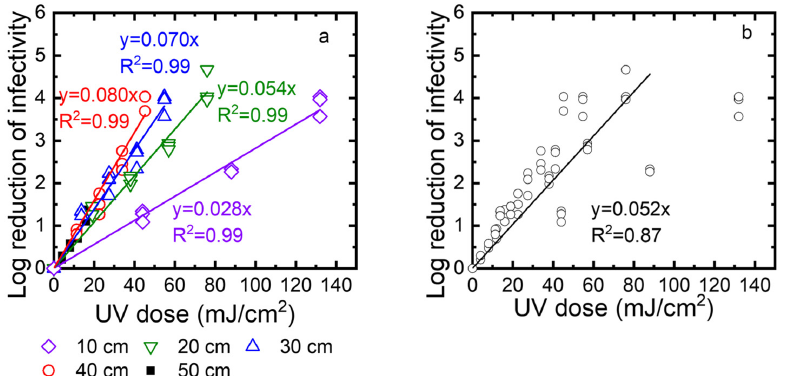
Figure 7. ( a ) Effect of UV dose and distance on the virus inactivation. ( b ) TV inactivation as a func- tion of the UV dose for distances of 10, 20, 30, and 40 cm. Note that the regression does not include the points for the highest UV dose obtained when the distance was 10 cm. Log reduction of infec- tivity is log 10 (N 0 /N), where N 0 is the infectivity of the viral suspension before exposure to UV, and N is the infectivity of this suspension after UV exposure.